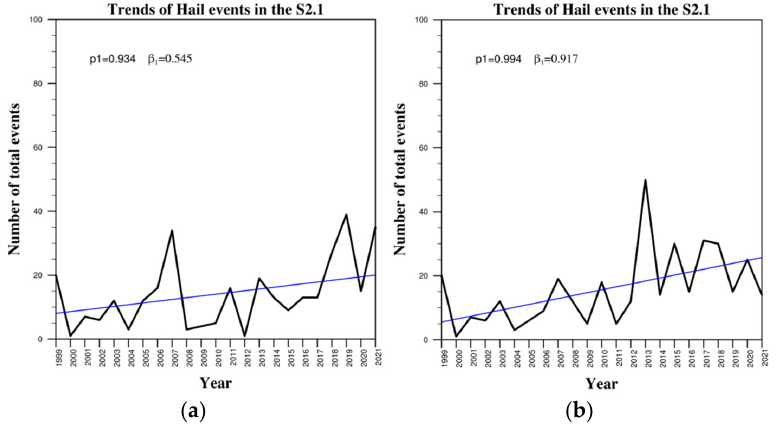
Figure 11. Temporal evolution of the annual number of H events for the sector 2.1 considering the time series-2 N15-N18-MOB ( a ), and time series-3 N15-MOA-MOC ( b ). Blue line displays the ten- dency of series.